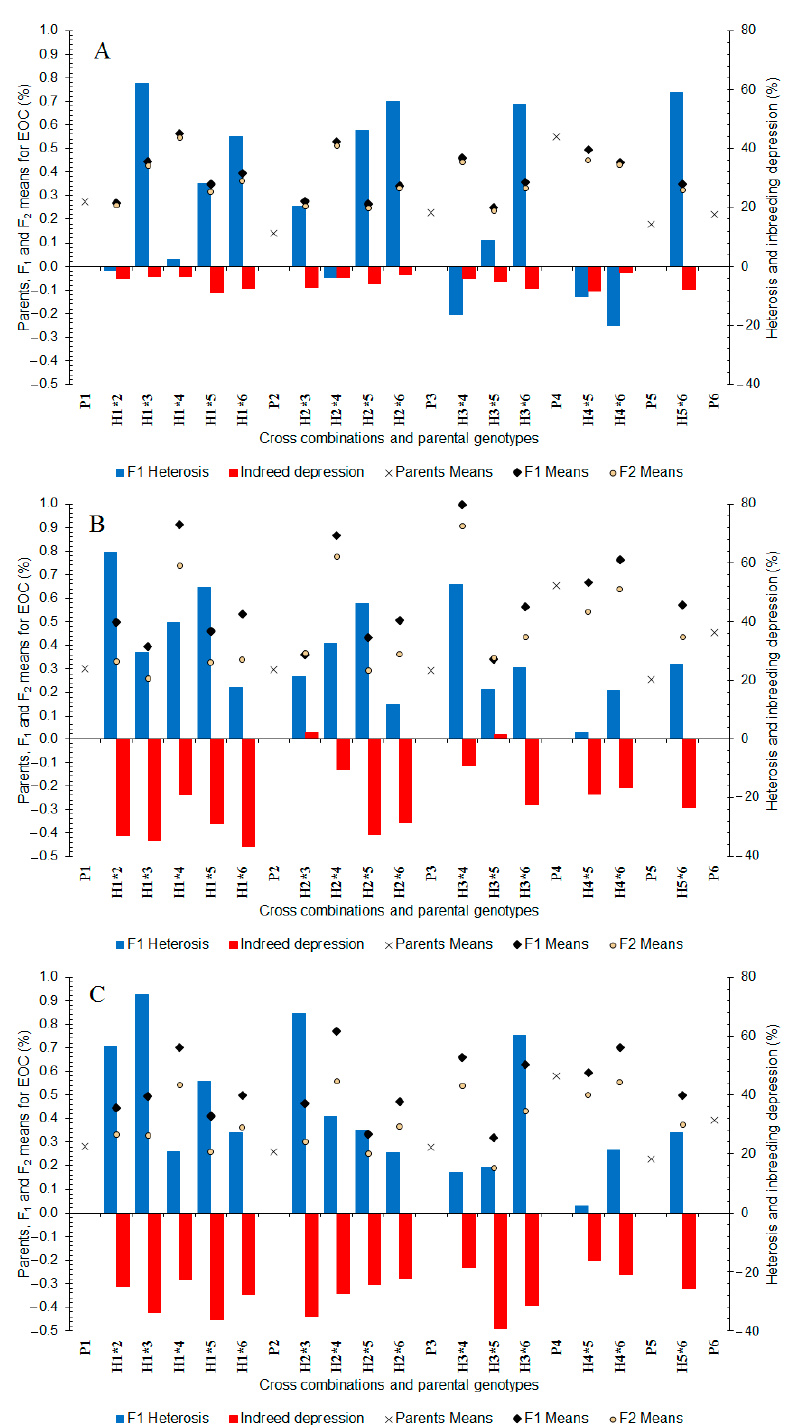
Figure 2. Mean, heterosis, and inbreeding depression for essential oil content in F 1 and F 2 genera- tions of coriander crosses. ( A ) Well-Watered, ( B ) Moderate Water Stress, and ( C ) Severe Water Stress. P 1 –P 6 : six parental coriander genotypes; H 1×2 –H 5×6 : 15 half-diallel hybrids. six parental coriander genotypes; H 1 × 2 –H 5 × 6 : 15 half-diallel